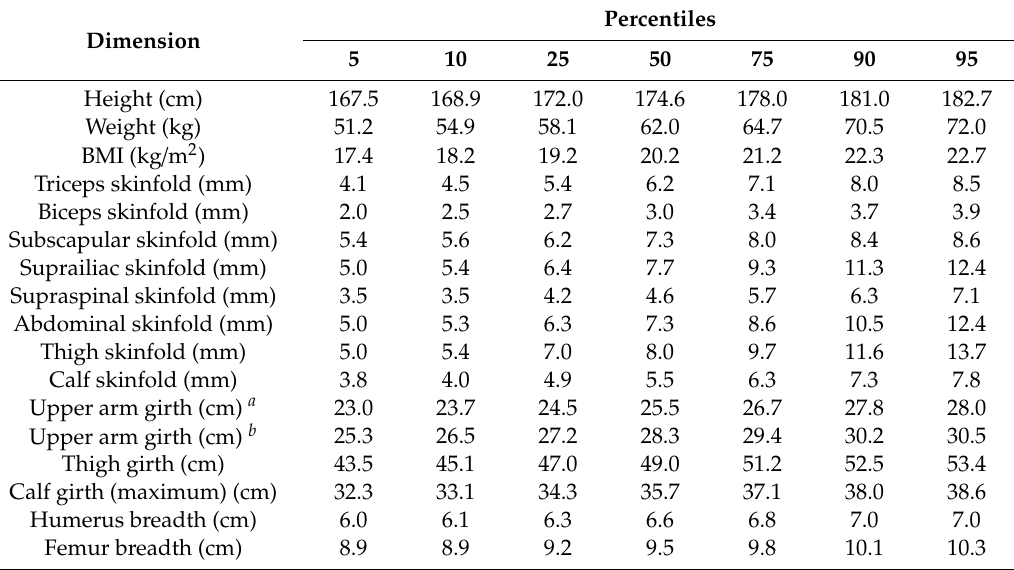
Table 3. Anthropometric profile chart for young elite runners (N = 90).